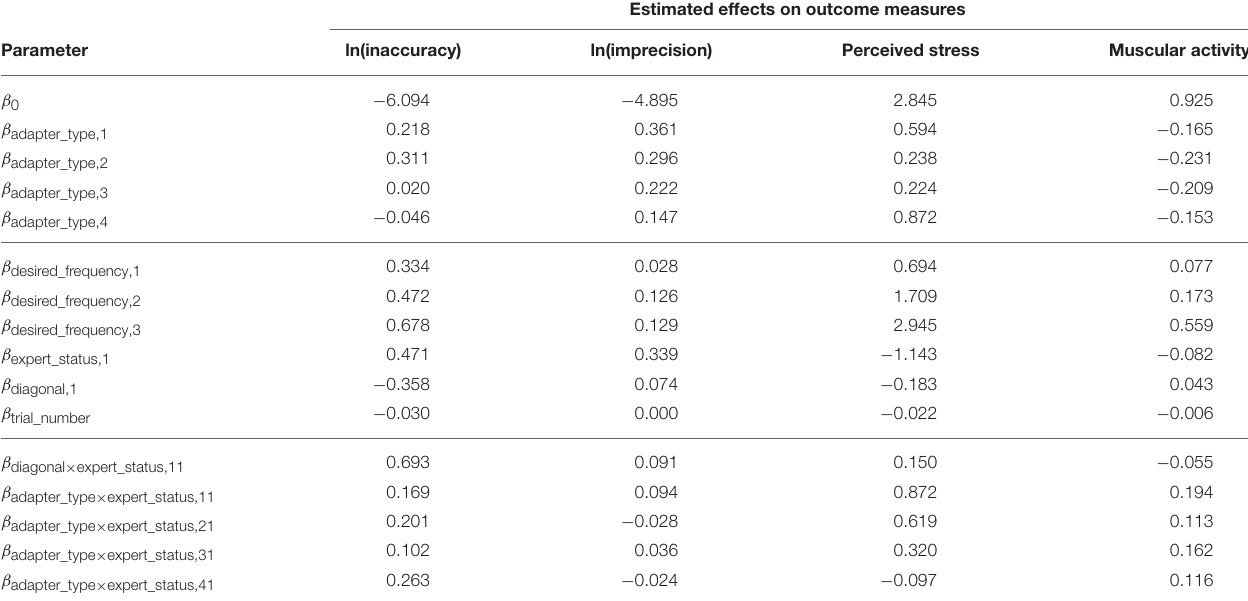
TABLE 4 | Estimates for the parameters of the fitted linear mixed models in Equation